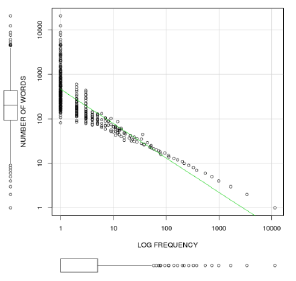
Figure 3. Distribution of unique word frequency in the Old Icelandic Legendary Sagas. As expected, the corpus follows a logarithmic distribution. IceMorph takes advantage of the universal fact that relatively few unique words in a corpus tend to occur with high